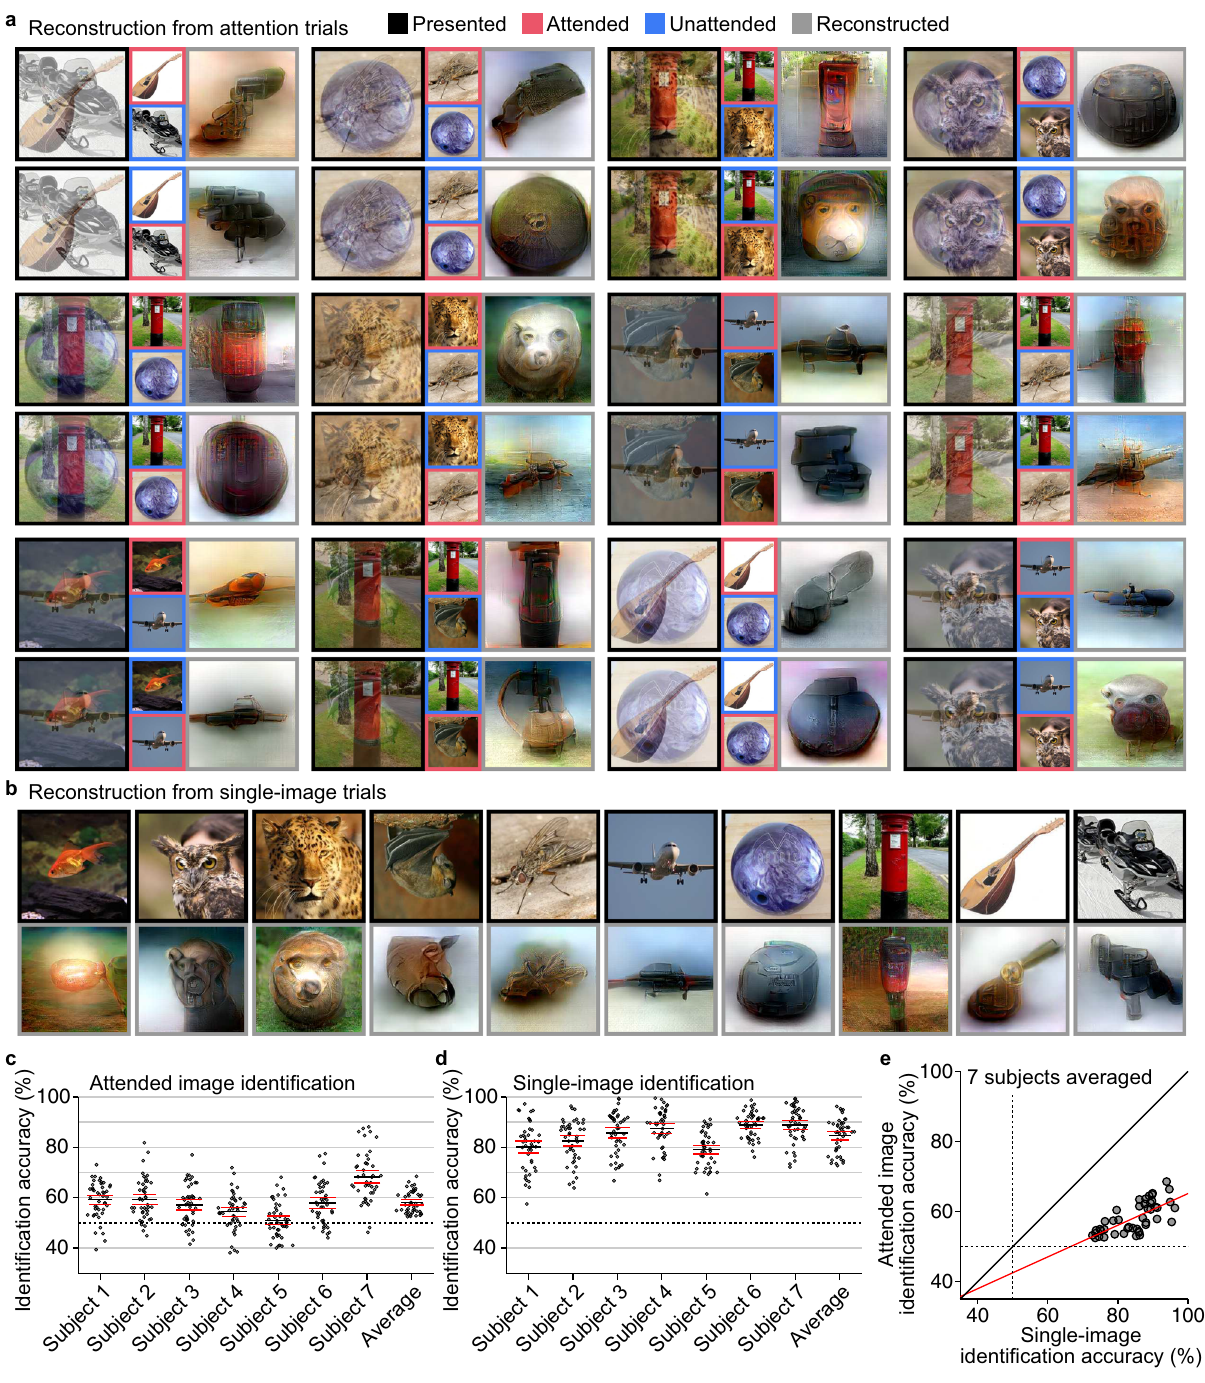
Fig. 2 Reconstructions from individual attention and single-image trials. a Reconstructions from attention trials. Reconstructions with relatively high rating accuracies are shown (see Supplementary Fig. 2 for more examples; see Methods: “ Evaluation of reconstruction quality ” ). For each speci fi c presented image, two reconstructions from the same subjects are shown for trials with different attention targets. b Reconstructions from single-image trials. Images with black and gray frames indicate presented and reconstructed images, respectively (see Supplementary Fig. 1c for more examples). c Identi fi cation accuracy based on behavioral evaluations for attended image reconstructions. Dots indicate mean accuracies of pair-wise identi fi cation evaluations averaged across samples for each paired comparison (chance level, 50%; see Methods: “ Evaluation of reconstruction quality ” ). Black and red lines indicate mean and lower/upper bounds of 95% C.I. across pairs. d Identi fi cation accuracy based on behavioral evaluations for single-image reconstructions. Conventions are the same with Fig. 2c. e Scatter plot of attended and single-image identi fi cation accuracy based on behavioral evaluations. Dots indicate mean accuracies averaged over samples for each paired comparison and subject. The red line indicates the best linear fi